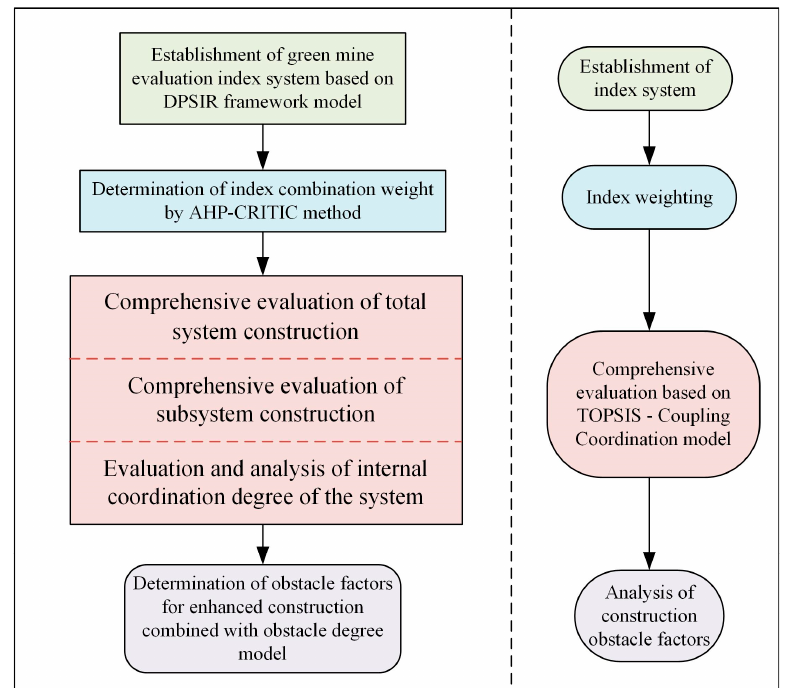
Figure 2. Flow Chart of Green Mine Assessment.